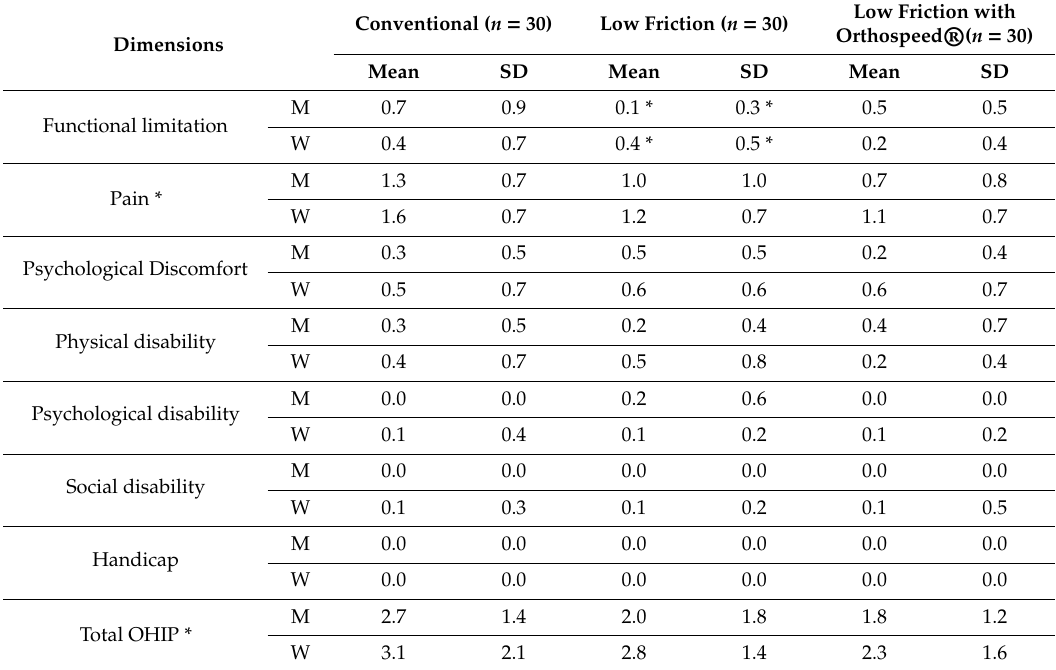
Table 5. Linear correlation between the sex of the individual and the impact on oral quality of life throughout the study groups according to the Oral Health Impact Profile